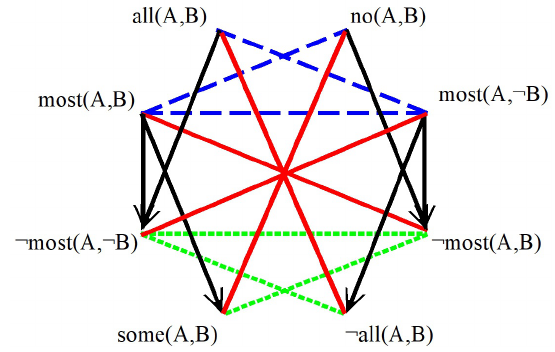
Figure 5. Octagon for F allmost , relative to FOL